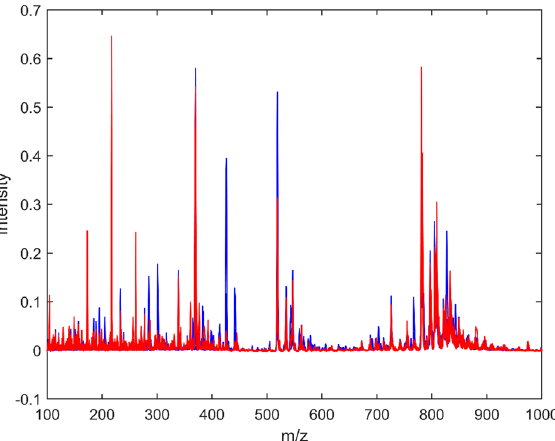
Figure 1. Baseline corrected mass spectra for the control group (blue) and FM group (red) obtained by PSI(-